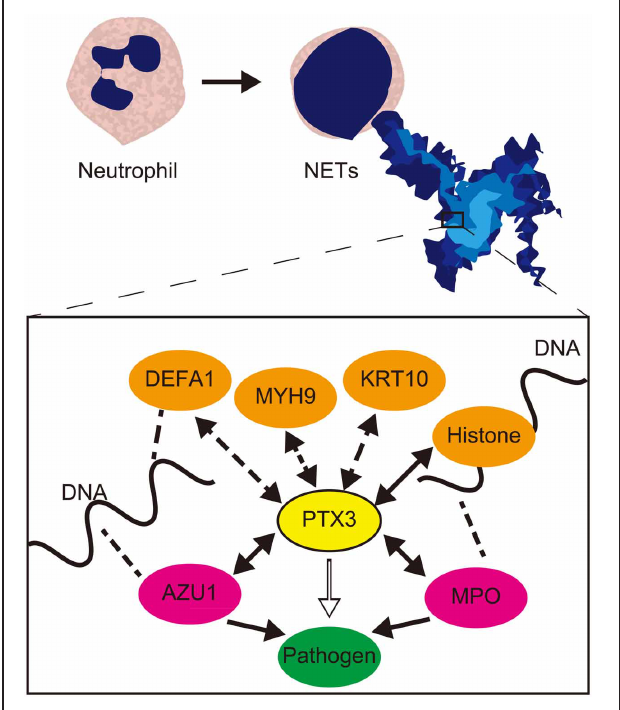
FIGURE 1 | Schematic relationship and role of PTX3 and NET component proteins in pathogen recognition and clearance. NET component proteins which were identified as PTX3 complex (Daigo et al., 2012) are associated PTX3 in NETs. Among these, the confirmed direct interaction of AZU1 and MPO to PTX3, and formerly reported histone-PTX3 interaction (Garlanda et al., 2005) are designated by two-way arrows. These bindings facilitate pathogen clearance efficiency of AZU1 and MPO. The pathogen recognition and anti-pathogenic action are designated by open arrow and closed arrow in box, respectively. Two-way arrows with dashed lines designate other potential interactions to PTX3. The indirect association to DNA via histone or basic proteins such as DEFA1, AZU1, and MPO, which DNA associations are designated by dashed lines, maintains PTX3 localization in NETs. PTX3, pentraxin 3; DEFA1, neutrophil defensin 1; MYH9, Myosn-9; KRT10, Cytokeratin-10; AZU1, azurocidin 1; MPO: